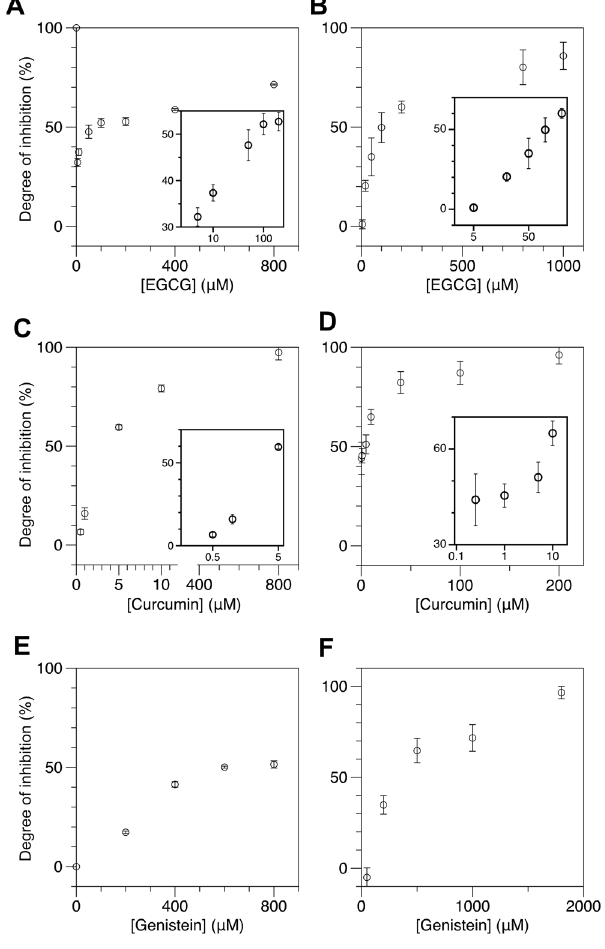
Figure 3. Natural dietary compounds suppress cytosine methylation in cores efficiently as revealed by reduced Z-DNA formation in the samples treated with those compounds. The concentration of SAM used was 160 μ M. FRET efficiency histograms for cores incubated with DMT in the presence of various kinds and concentrations of natural inhibitors are shown in Supplementary Materials, Figure S7. ( A , B ) DOI of DMT activity by EGCG at various concentrations (( A ) 5, 10, 50, 100, 200, 400, 800 μ M for M.SssI and ( B ) 5, 20, 50, 100, 200, 800, 1000 μ M for DNMT1). ( C , D ) DOI of DMT activity by curcumin at various concentrations (( C ) 0.5, 1, 5, 10, 800 μ M for M.SssI and ( D ) 0.25, 1, 5, 10, 40, 100, 200 μ M for DNMT1). ( E , F ) DOI of DMT activity by genistein at various concentrations (( E ) 200, 400, 600, 800 μ M for M.SssI and ( F ) 50, 200, 500, 1000, 1800 μ M for DNMT1). For EGCG and curcumin, the DOI values for low inhibitor concentrations are presented in insets with the inhibitor concentration in log scale.